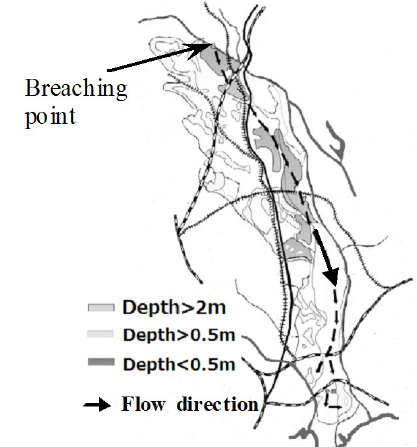
Figure 3. Floodwater pathways in 1947 based on historical